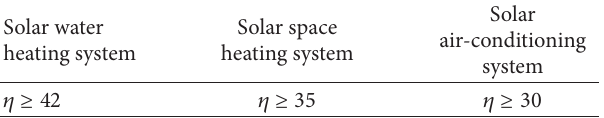
Table 2: Requirement for the efficiency of a solar collecting